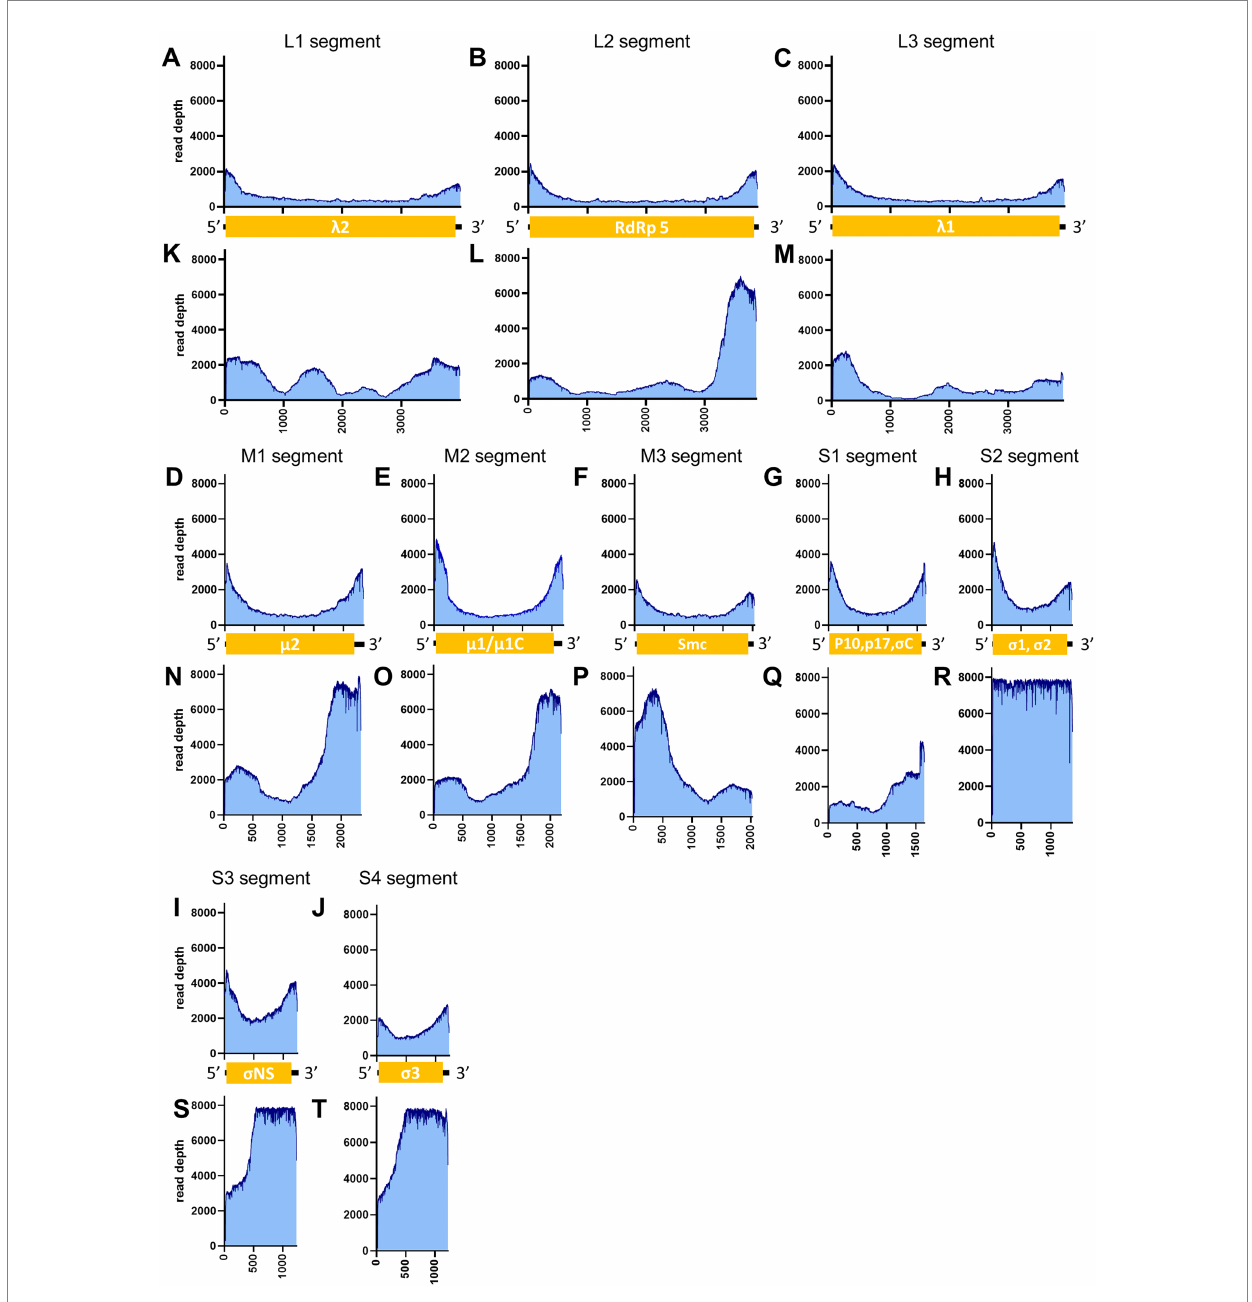
FIGURE 8 Read depth aligned to PRV reference genome. The data generated from the PCR-NGS method [upper panels: (A–J) ] or RCA-NGS method [lower panels: (K–T) ] aligned to the segments L1 (A,K) , L2 (B,L) , L3 (C,M) , M1 (D,N) , M2 (E,O) , M3 (F,P) , S1 (G,Q) , S2 (H,R) , S3 (I,S) and S4 (J,T) are shown. The number of reads (y-axis) obtained at each nucleotide base pair position (x-axis) is